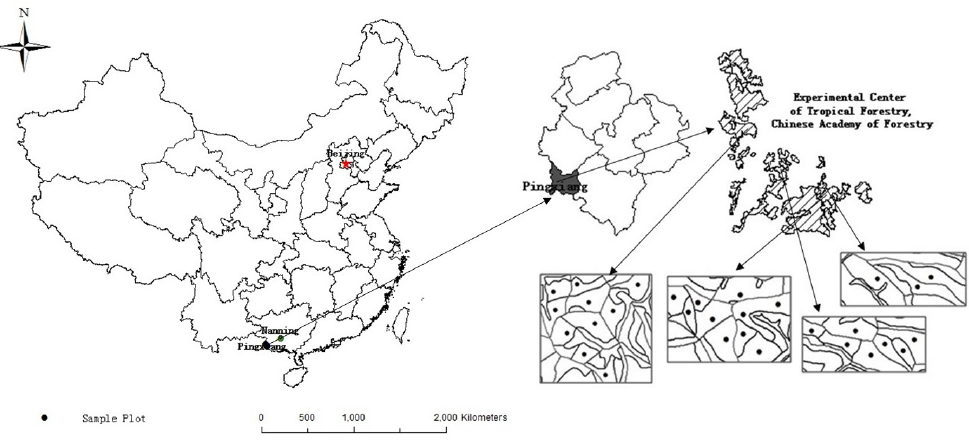
Figure 1. Location of study area: Experimental Center of Tropical Forestry, Chinese Academy of Forestry Sciences and spatial distribution of 30 sample plots. Table 1. Summary statistics of full dataset.